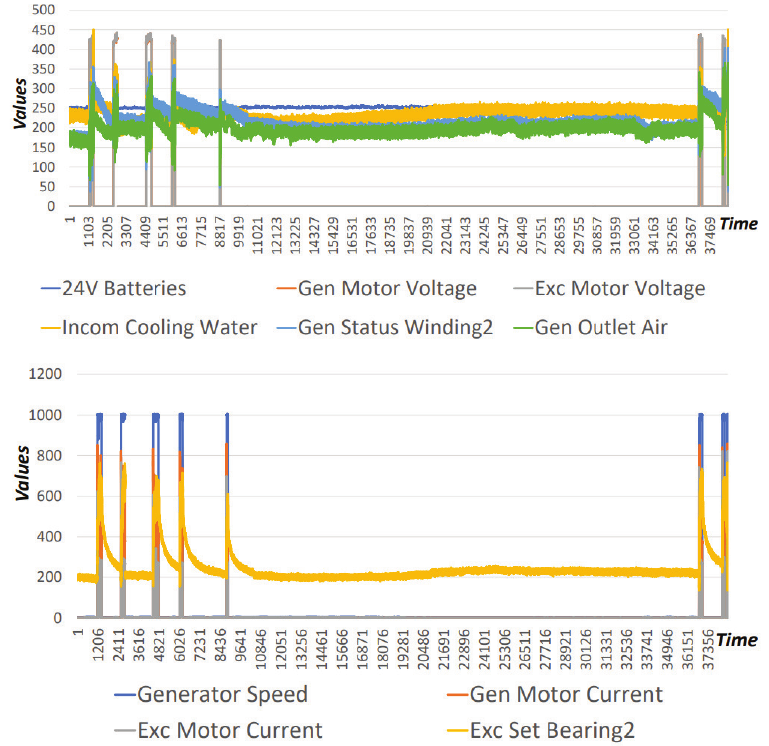
Figure 5. Operational Dataset (electricity